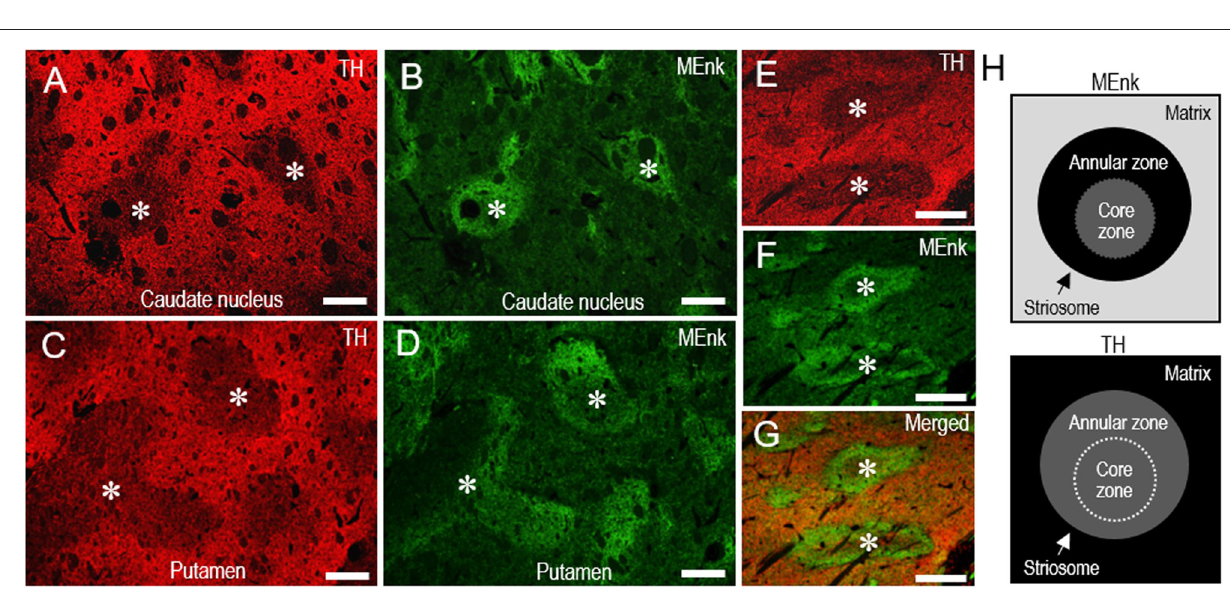
( Figure 4F ), compared with the striosomal area ( Figure 4G ).